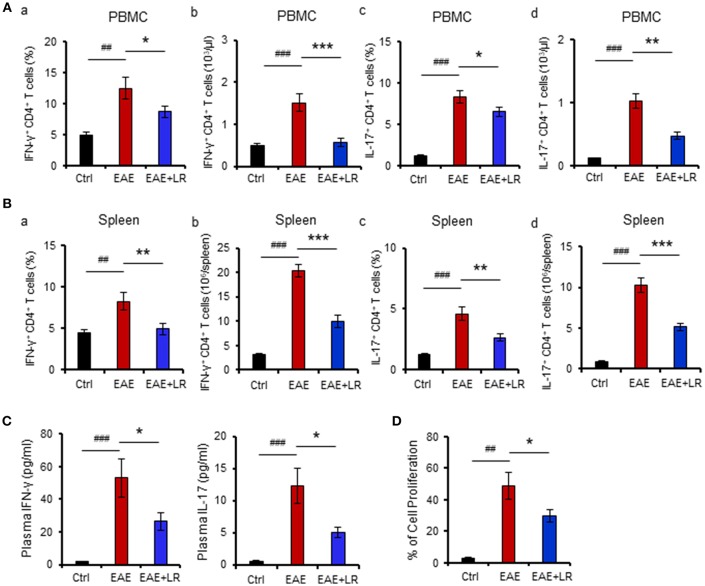
L. reuteri treatment decreases TH1/TH17 cells and their associated cytokines, and reduces MOG35−55-stimulated cell proliferation in EAE mice. (A) PBMCs. (a) the frequency of IFN-γ+ CD4+ T cells (TH1), (b) the absolute number of IFN-γ+ CD4+ T cells, (c) the frequency of IL-17+ CD4+ T cells (TH17), and (d) the absolute number of IL-17+ CD4+ T cells. (B) Spleen. (a) The frequency of IFN-γ+ CD4+ T cells, (b) the absolute number of IFN-γ+ CD4+ T cells, (c) the frequency of IL-17+ CD4+ T cells, and (d) the absolute number of IL-17+ CD4+ T cells. (C) Plasma IL-17 and IFN-γ levels. (D) The percentage of cell proliferation of splenocytes isolated from the mice at d12 post-immunization responded to in vitro MOG35−55 stimulation (see Materials and Methods) in Ctrl, EAE, and EAE+LR mice (n = 10 mice per group). Data are presented as mean ± SEM. In vitro stimulation assays of PBMCs and splenocytes were performed in triplicate. *p < 0.05, **p < 0.01,***p < 0.001. EAE+LR vs. EAE. ##p < 0.01, ###p < 0.001. EAE vs. Ctrl.